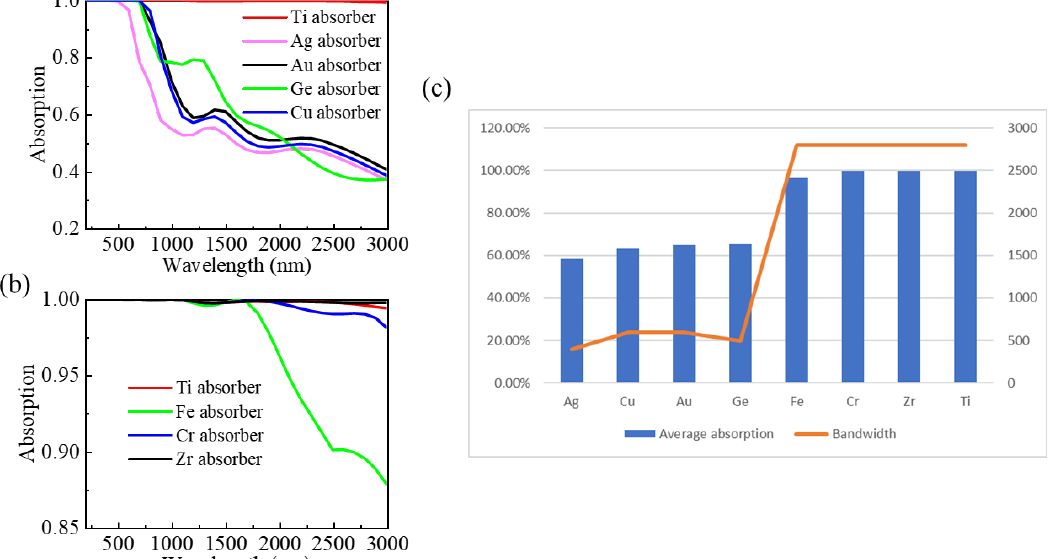
Figure 8. ( a ) Simulation results of different materials by keeping the SiO 2 dielectric film unchanged and replacing Ti material with common metals Au, Ag, Cu, and Ge; ( b ) simulation results of differ- ent materials by keeping the SiO 2 dielectric film unchanged and replacing the Ti material with re- fractory metals Zr, Cr, and Fe; ( c ) the average absorption efficiency and the broadband absorption of over